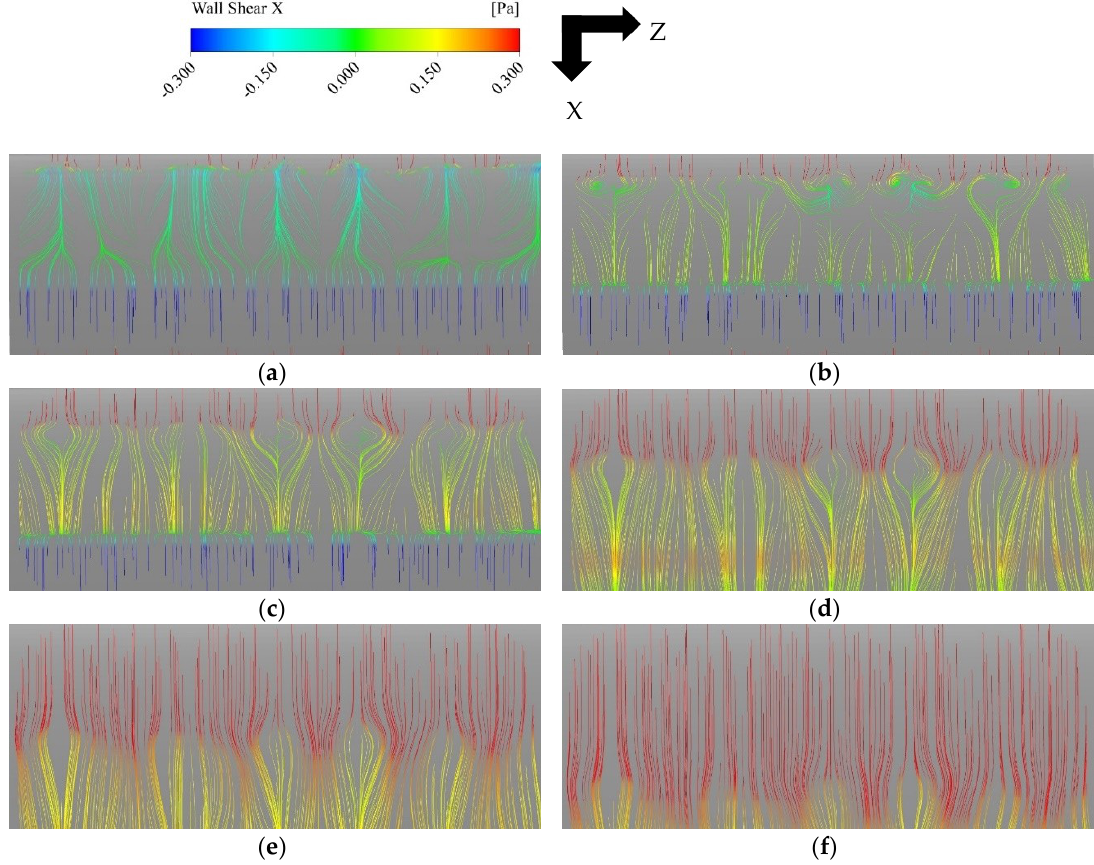
Figure 8. 3D flow structures on the aerofoil surface. Maximum AoA = 24°, f = 0.1. ( a ) AoA = 13.81° ↓ ; ( b ) AoA = 12.79° ↓ ; ( c ) AoA = 11.75° ↓ ; ( d ) AoA = 9.64° ↓ ; ( e ) AoA = 7.53° ↓ ; ( f ) AoA = 5.46° ↓ .